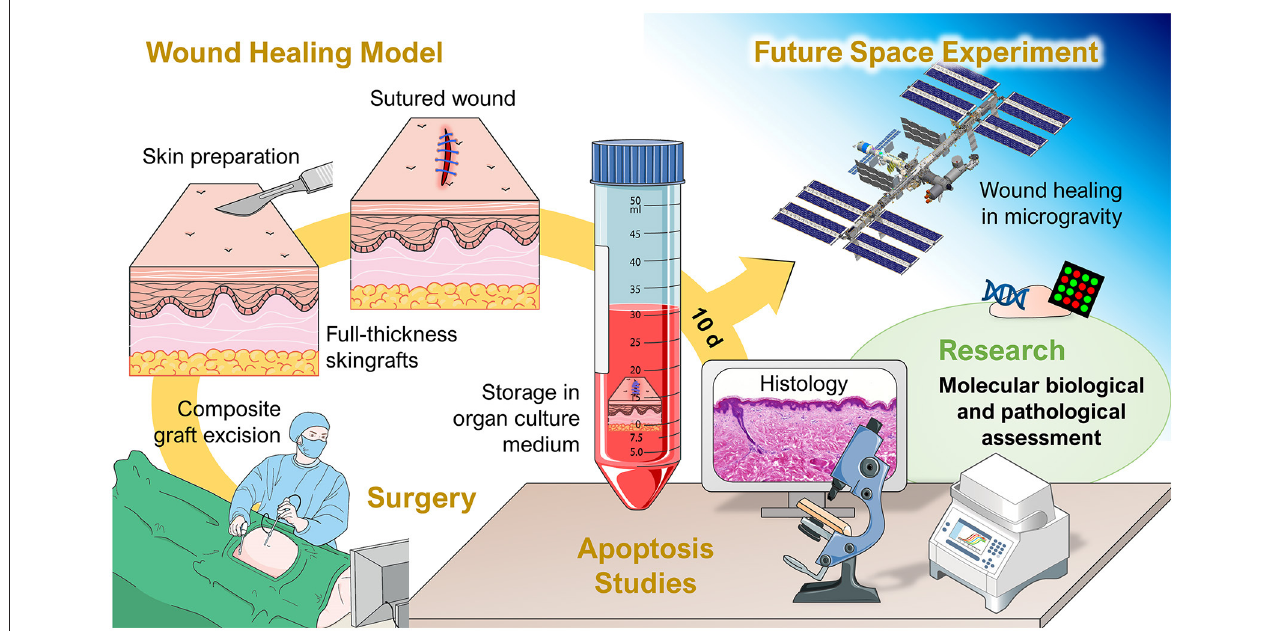
FIGURE 4 | Overview of the project “Wound Healing and Sutures in Unloading Conditions.” Parts of the figure are drawn using pictures from Servier Medical Art (https://smart.servier.com), licensed under a Creative Commons Attribution 3.0 Unported License